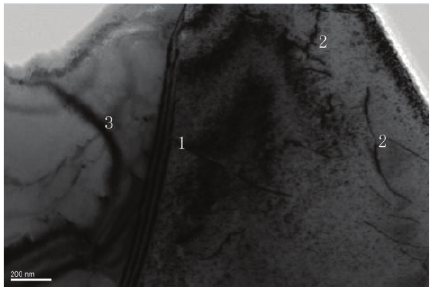
Figure 9: Double-beam approximate bright contrast image of 𝛽